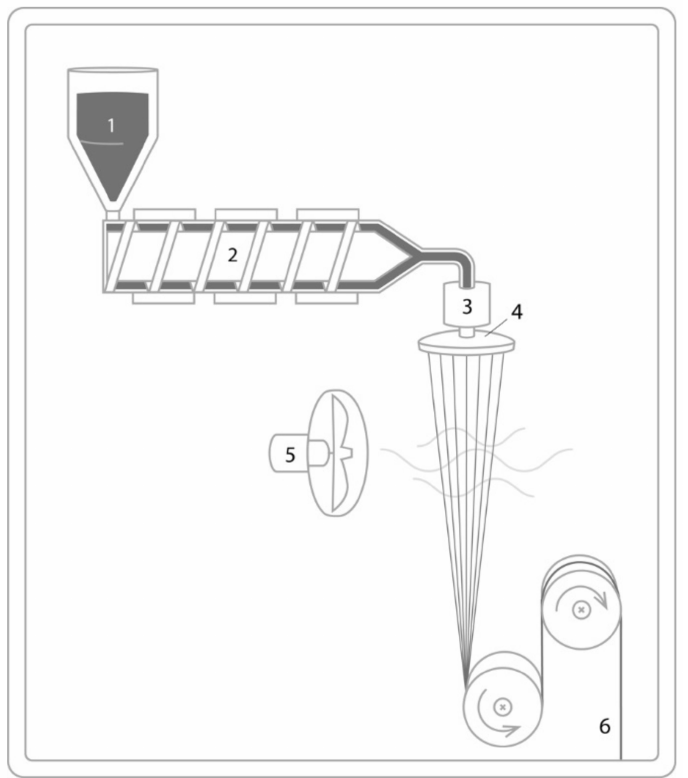
Figure 3. Schematic drawing of melt spinning with a polymer feeder (1), extruder with a single screw (2), the feed pump and nozzle (3), the spinneret (4), cooling air (5) and the winding station (6). In dry spinning, a solvent is used to dissolve the raw material to form a solution and